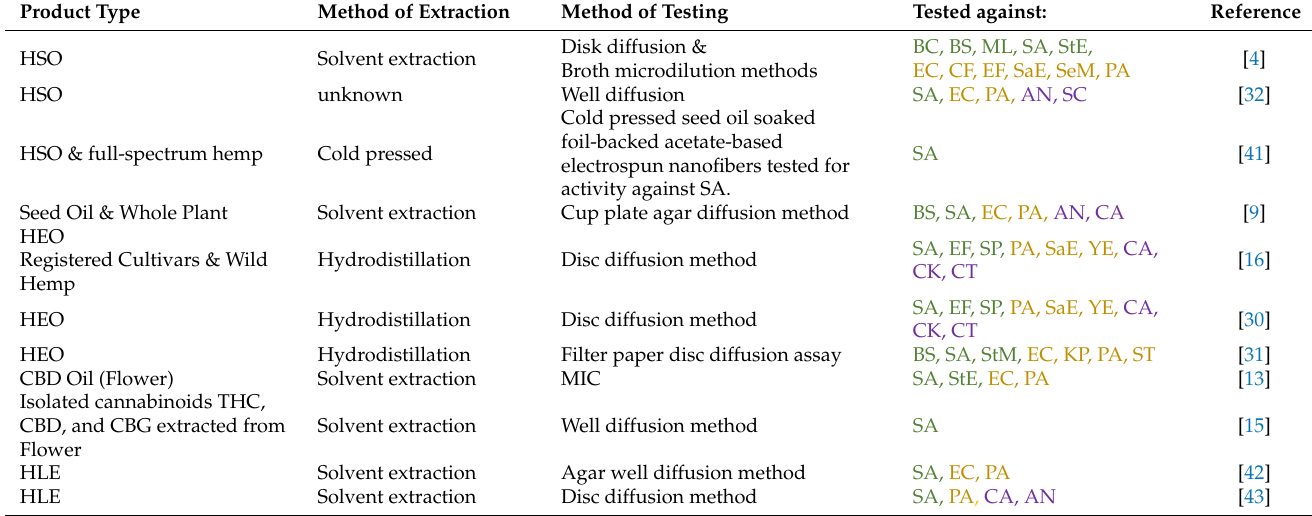
Table 1. A Summary of Antimicrobial Effects of Hemp Derived